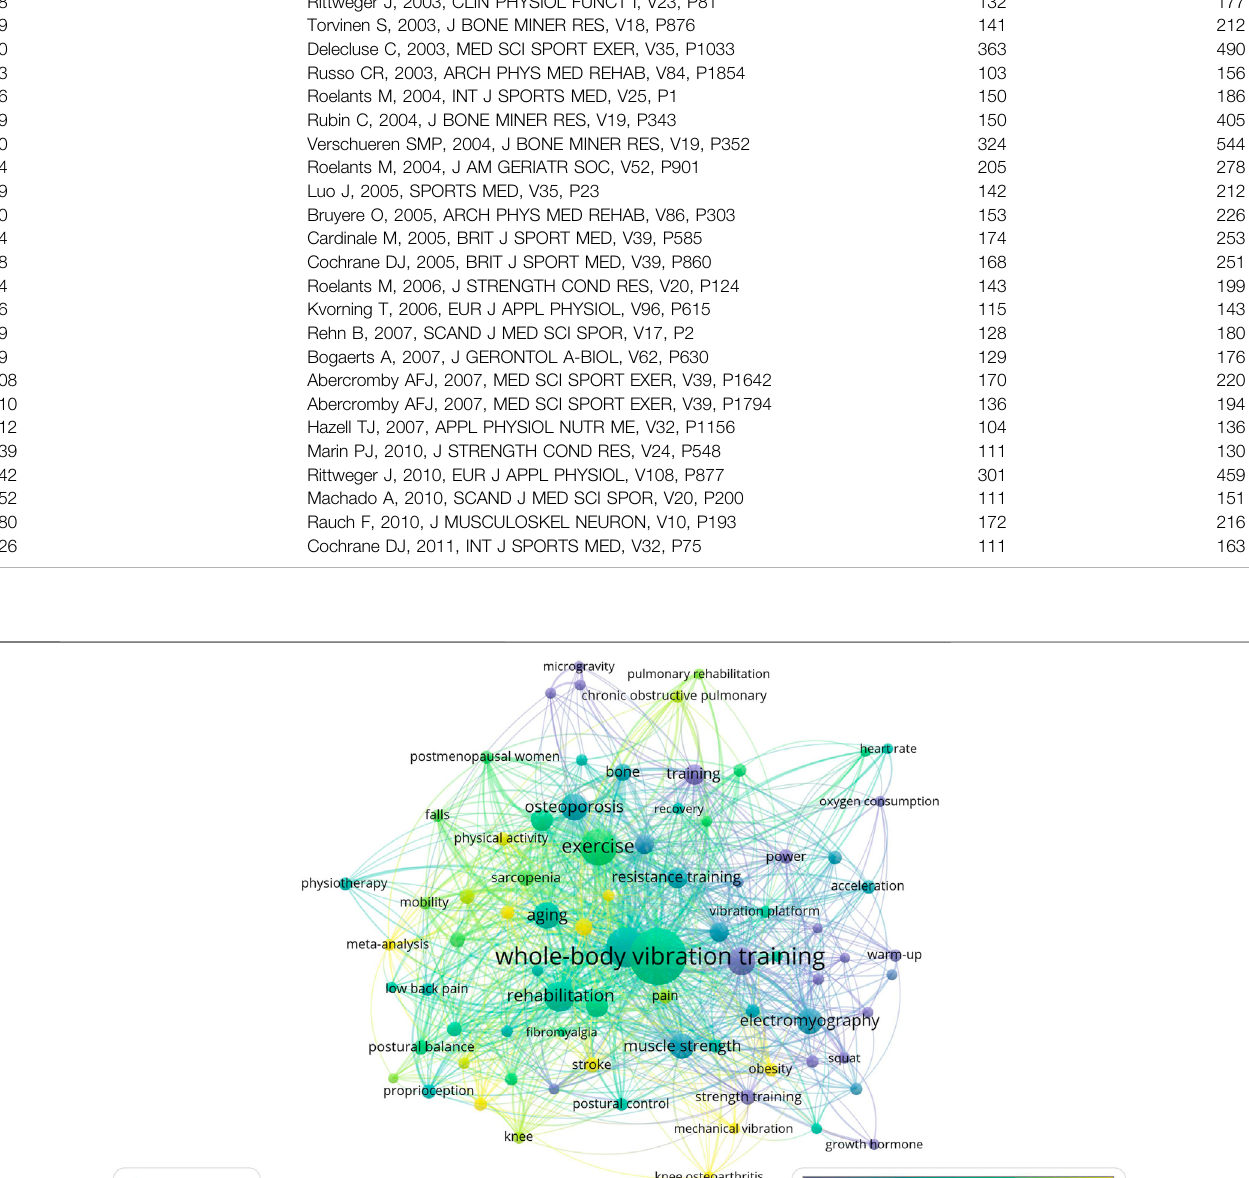
Frontiers in Bioengineering and Biotechnology |